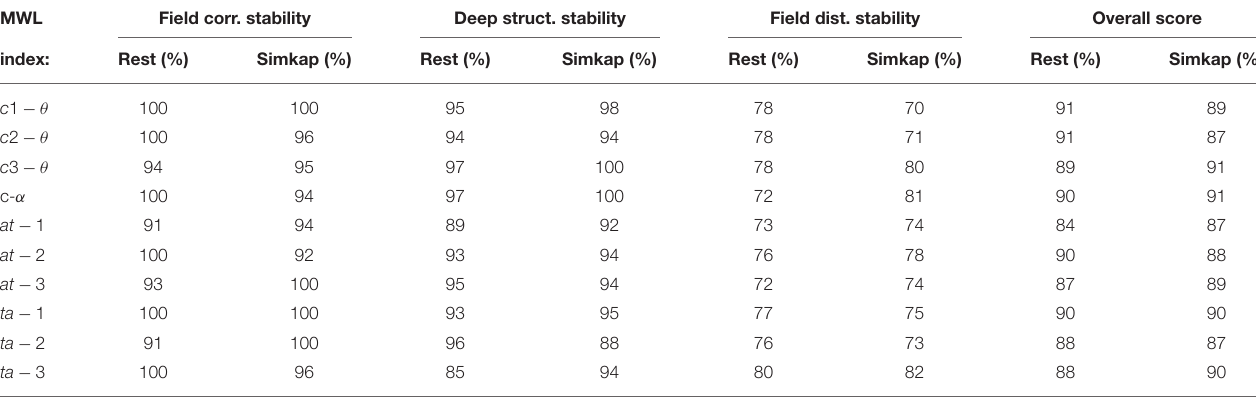
TABLE 2 | Synthetic score for different mental workload indexes and two task load conditions (“Rest” and “Simkap”). MWL Field corr. stability Deep struct. stability Field dist.